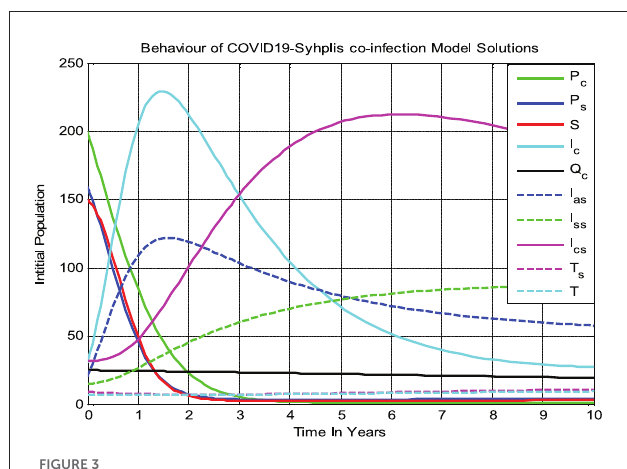
FIGURE3 Behaviors of the full model solutions whenever R cs 0 > 1 at β 1 = 8 and β 2 =